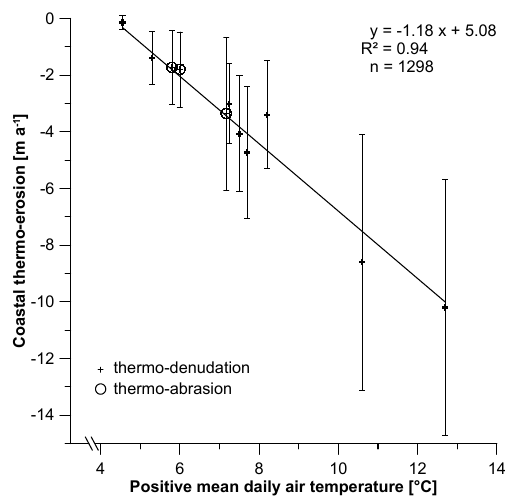
Figure 17. Mean annual coastal thermo-erosion (eight data points for TD and three for TA) vs. positive mean daily T air . Each erosion data point is a mean of all 118 coastal sections; error bars indicate standard deviation of rates. T air was calculated for specific observa- tion periods using only days with mean T air > 0 ◦ C.